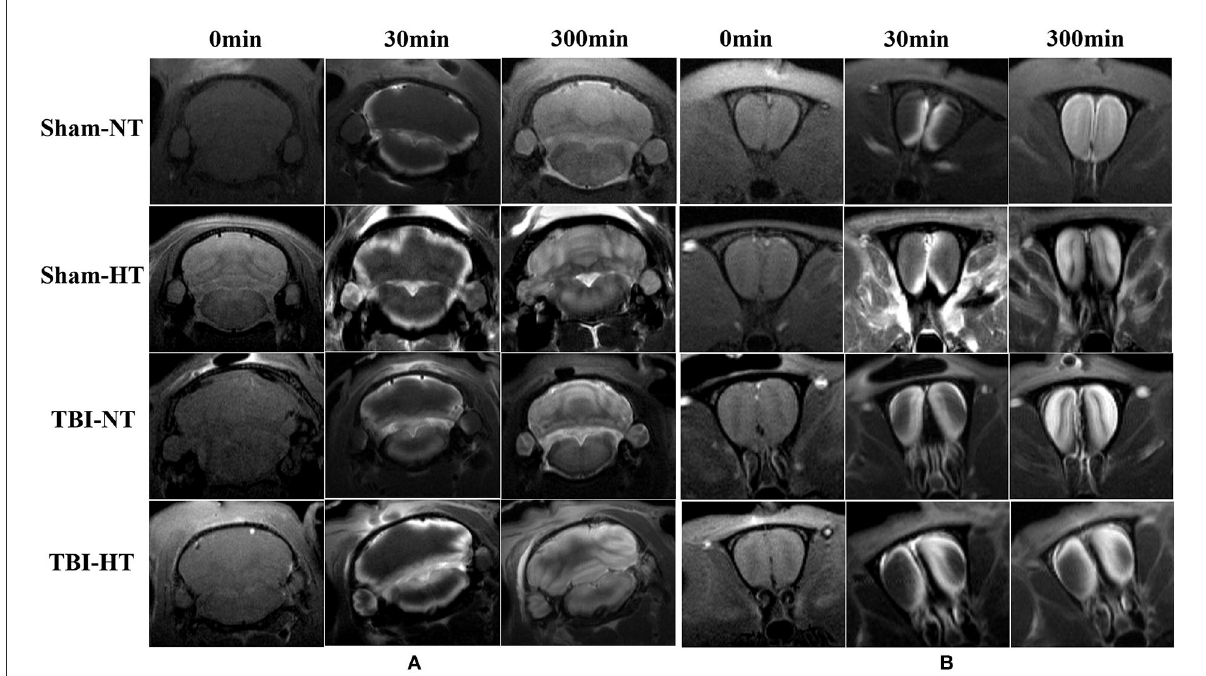
FIGURE7 Contrast distribution in the cerebellum and olfactory bulb of TBI and sham injury rats after intrathecal infusion of low molecular weight contrast agent Magnevist. (A) The time series of coronal T1-weighted MRI images demonstrates a symmetrical distribution pattern with different infusion speeds in cerebellum of Sham-NT, Sham-HT, TBI-NT, and TBI-HT animal brain from early influx (0–30min) to the end of the experiment (300min). (B) Besides different infusion speeds, an asymmetrical distribution pattern is also detected in the olfactory bulb in TBI-NT and TBI-HT, but not in sham injury controls during the same experiment